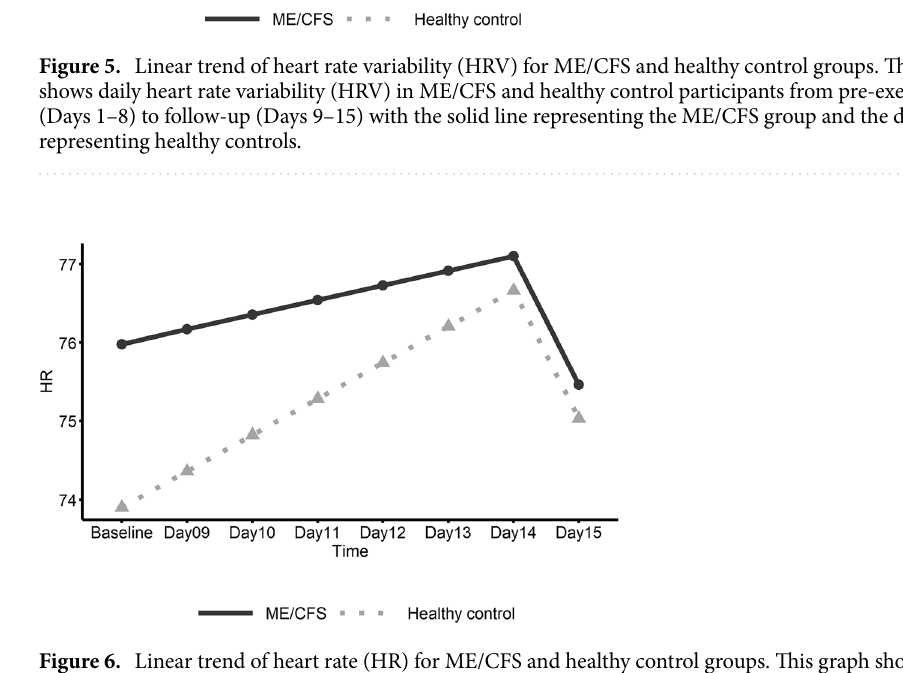
Figure 6. Linear trend of heart rate (HR) for ME/CFS and healthy control groups. This graph shows daily heart rate (HR) in ME/CFS participants from pre-exercise Baseline (Days 1–8) to follow-up (Days 9–15) with the solid line representing the ME/CFS group and the dashed line representing healthy controls.